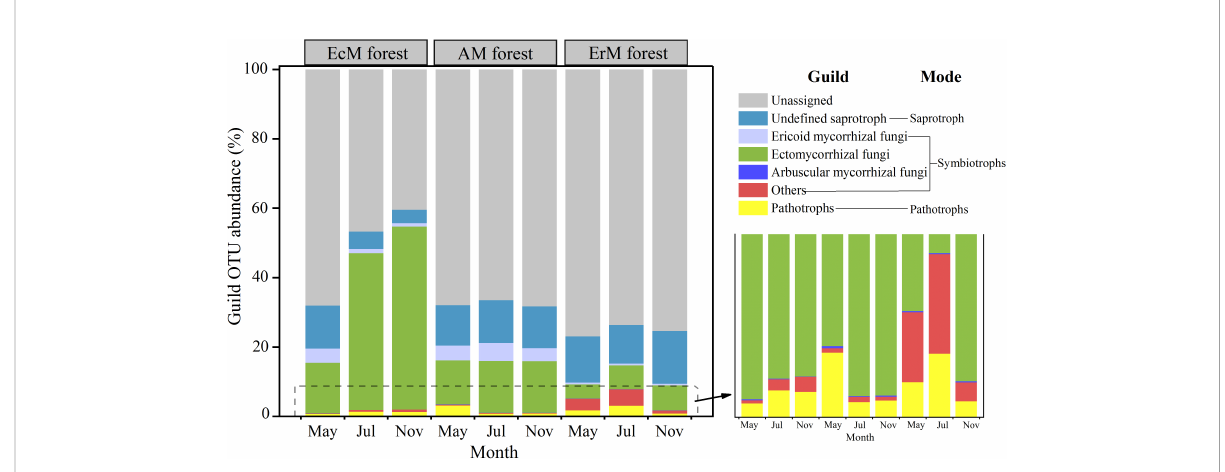
FIGURE 4 Composition of soil fungal functional guilds among three mycorrhizal forests in each different sampling month. EcM forest, Abies fargesii var. faxoniana primary forest; AM forest, Cupressus chengiana primary forest; ErM forest, Rhododendron phaeochrysum primary forest. ‘ Others ’ include endophyte and lichenized. Pathotrophs include animal pathogen, plant pathogen and mycoparasites. The lower right corner is a partial